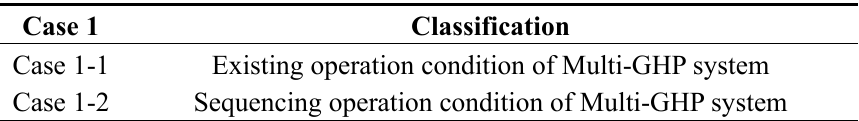
Table 6. Summary of the operation cases of the Multi-GHP